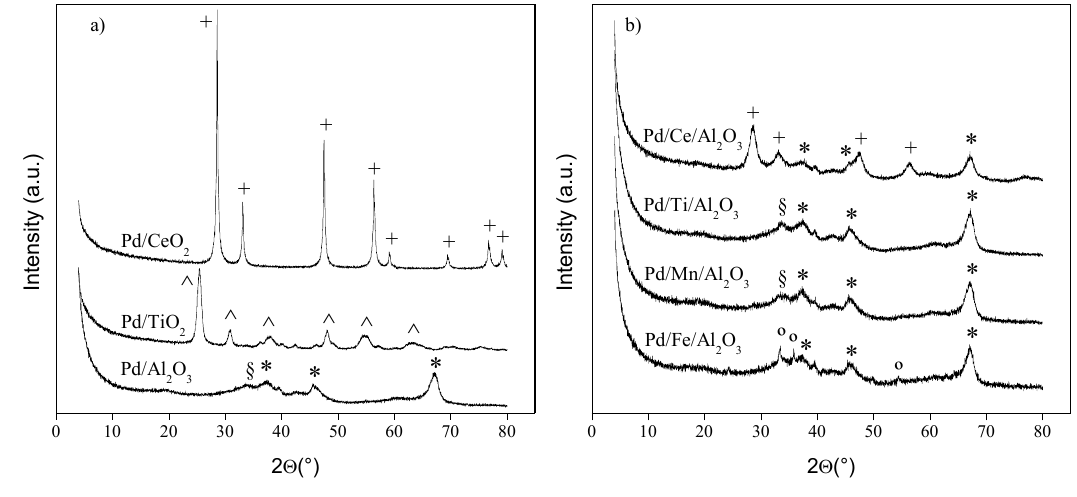
Figure 2. XRD profiles of ( a ) Pd-supported catalysts and ( b ) Pd-doped-supported catalysts, where § denotes reflection of PdO, * denotes reflection of γ-Al 2 O 3 , + denotes reflection of CeO 2 , ^ denotes reflection of TiO 2 and ° denotes reflection of Fe 2 O 3